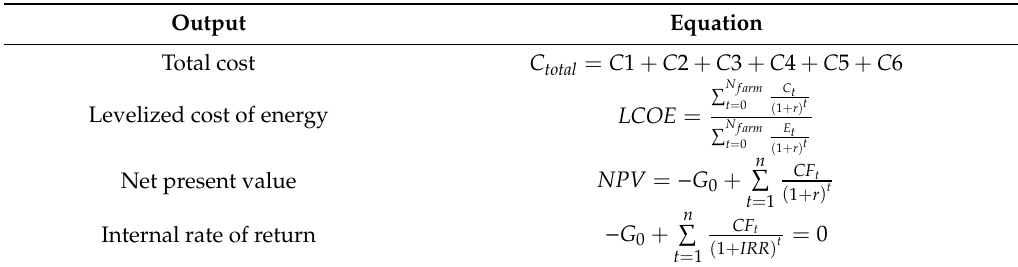
Table 4. Output criteria.